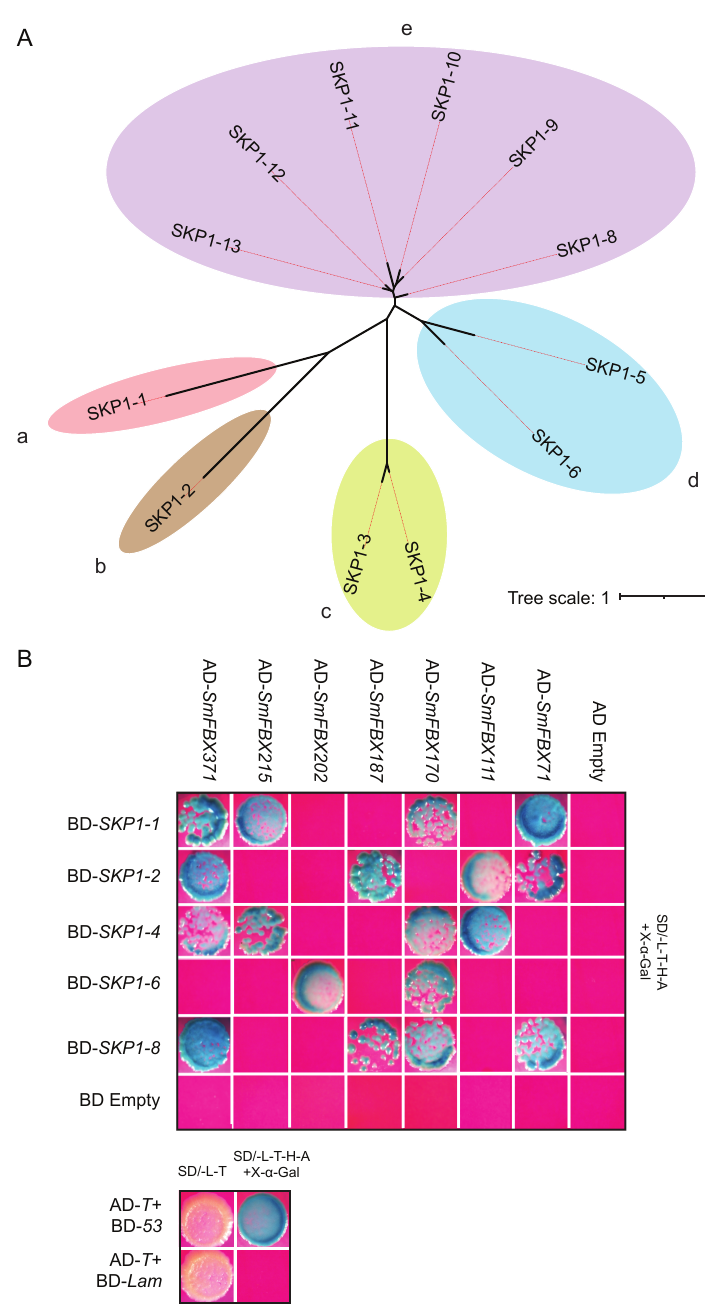
Figure 5. The representative Skp1s interacted with the F-box candidate proteins screened in the Y2H system. ( A ) The Skp1-like proteins in eggplant were screened, and an unrooted phylogenetic tree was constructed. Notably, a–e represent different subfamilies of Skp1-like proteins. Each subfamily is represented by a different color block. ( B ) Selected representative Skp1s interacted with the representative F-box candidate proteins. The F-box genes were constructed in the pGADT7 (AD) vector, and the Skp1-like genes were constructed in the pGBKT7 (BD) vector. After co-transforming Y2H Gold yeast competent cells, the yeast plaques could grow on the four-deficient plates, and the plaques could be stained blue by X- α -Gal. This suggests that the two proteins can interact with each other. The growth of yeast cells after AD-T co-transfection with BD- 53 or BD- Lam was the positive and negative control, respectively. SD/-L-T and SD/-L-T-H-A, SD media that lack two and four amino acids, respectively. Y2H, yeast hybrid